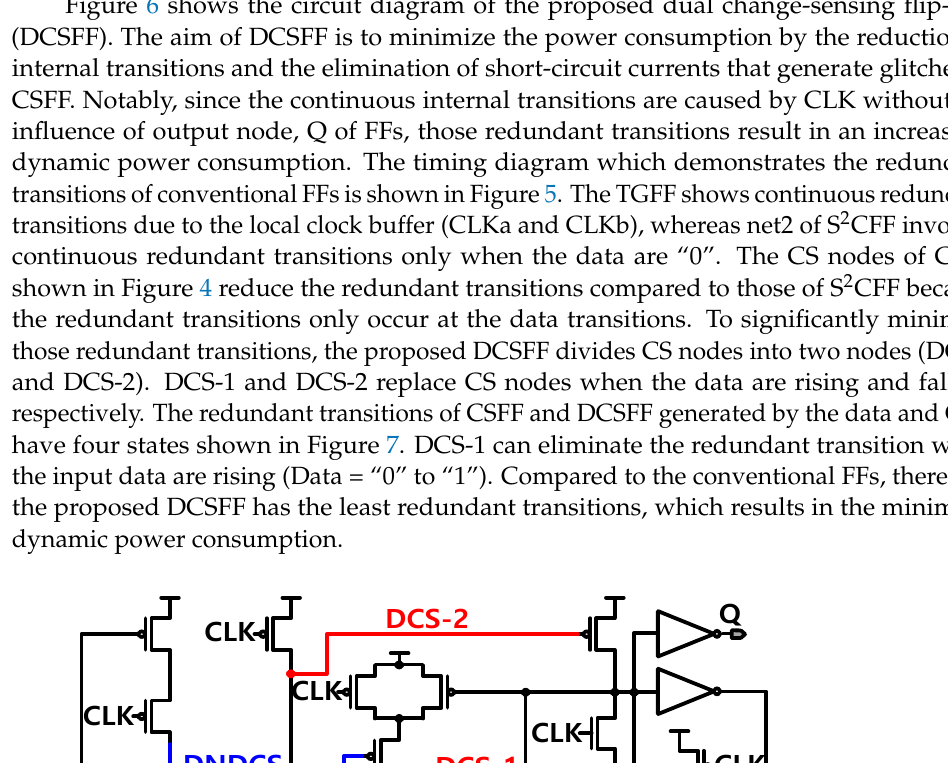
Figure 5. Timing Diagram of Redundant Transitions between the Proposed One and Others.